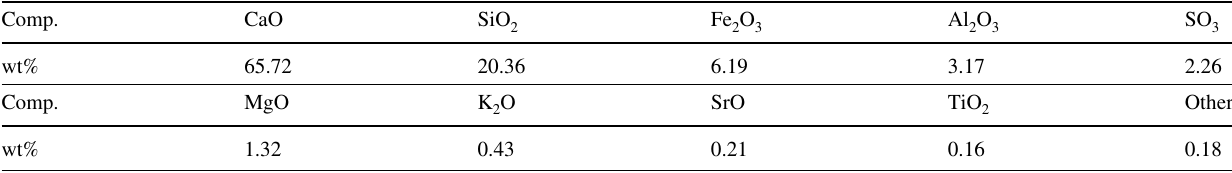
Table 1 Chemical composition of Class H cement